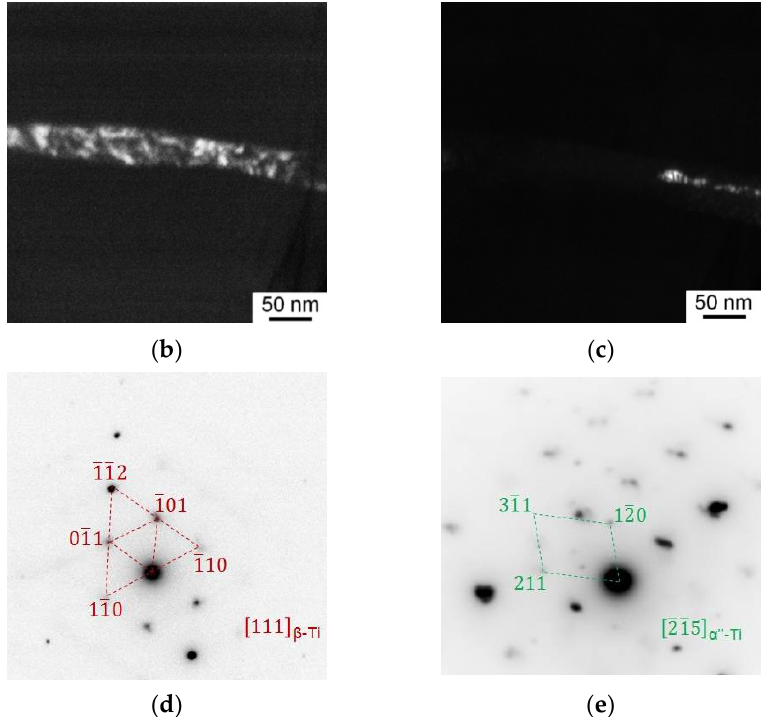
Figure 7. TEM bright- ( a ) and dark-field ( b , c ) images and an associated SAED pattern with an indexing scheme ( d , e ) illustrating the microstructure of the Ti-6Al-4V samples subjected to UIT. The micrographs were obtained at a depth of 45 µm below the treated surface. The dark-field micrographs were obtained with the 1(cid:3364)1(cid:3364)2 β-Ti ( b ) and 12(cid:3364)0 α”-Ti ( c ) reflections.